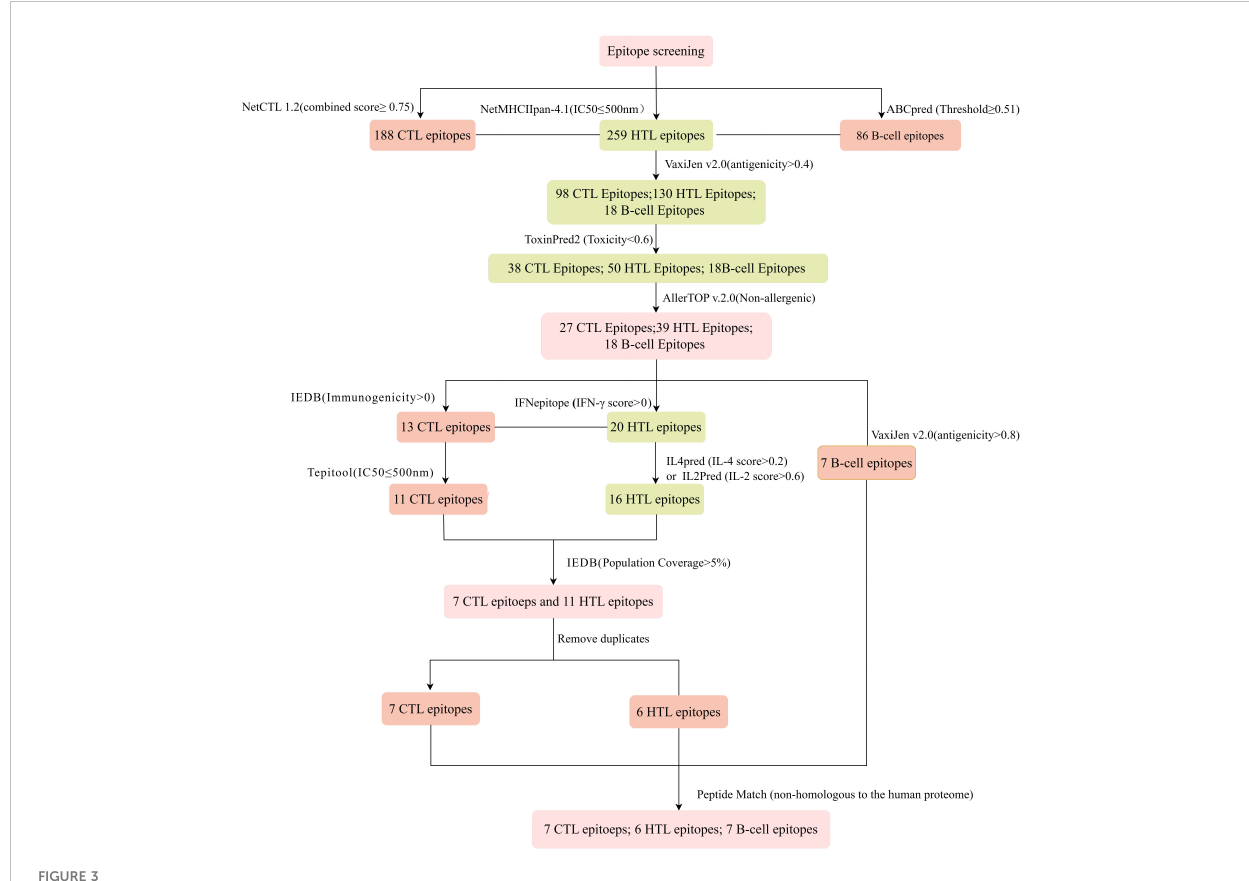
FIGURE 3 Flowchart of the epitope